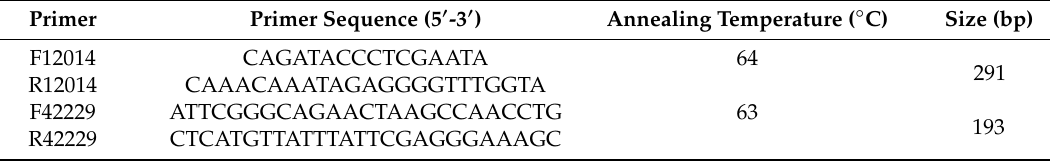
Table 2. Information of primer for selecting single nucleotide polymorphism (SNP)s.